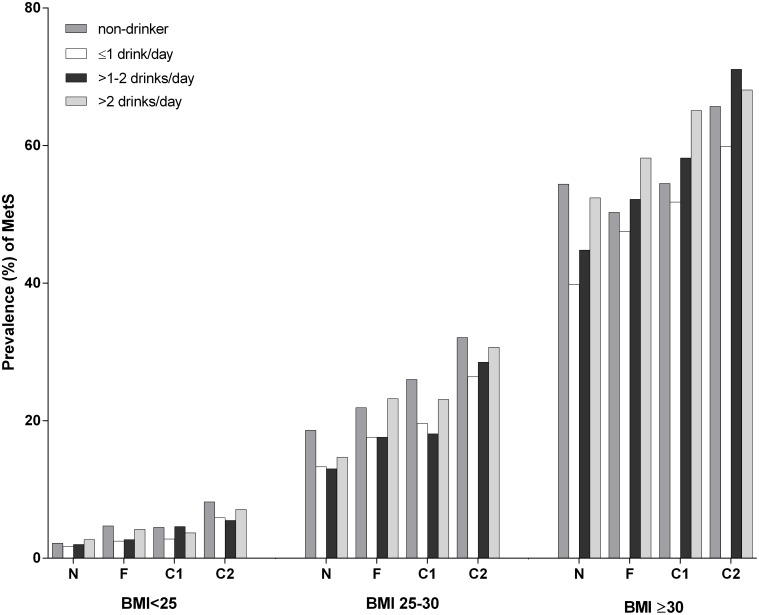
Prevalence of metabolic syndrome within the smoking and alcohol subgroups, according to BMI class.Top: BMI<25 kg/m2; middle: BMI 25–30 kg/m2; bottom: BMI≥30 kg/m2. BMI = body mass index N: non-smokers; F: former smokers; C1: smokers of <20 g tobacco/day; C2: smokers of ≥20 g tobacco/day.